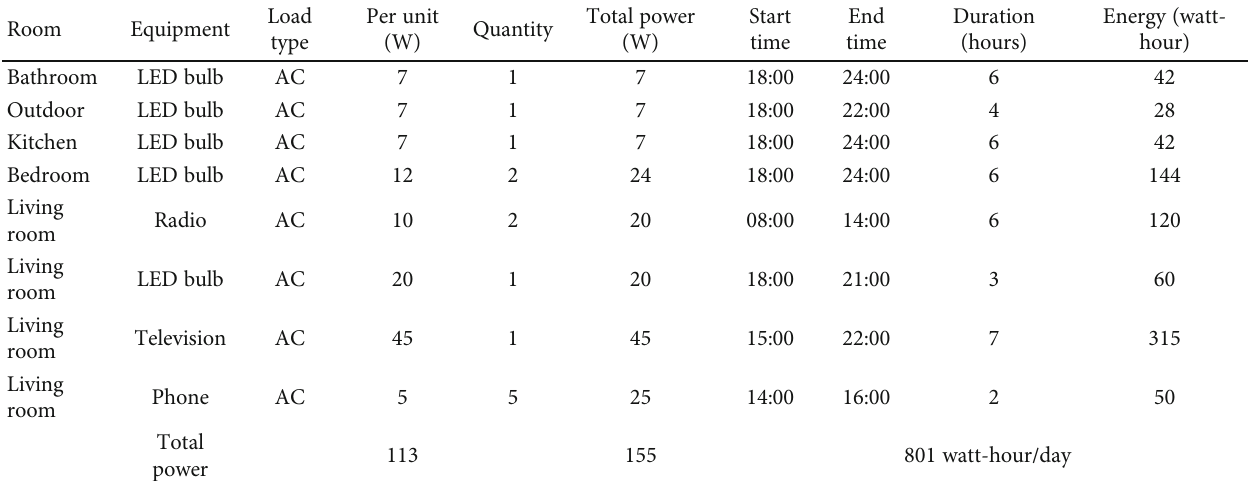
Table 1: Two-bedroomed nominal power peak-hour energy consumption for middle-income earner in Zambia. Room